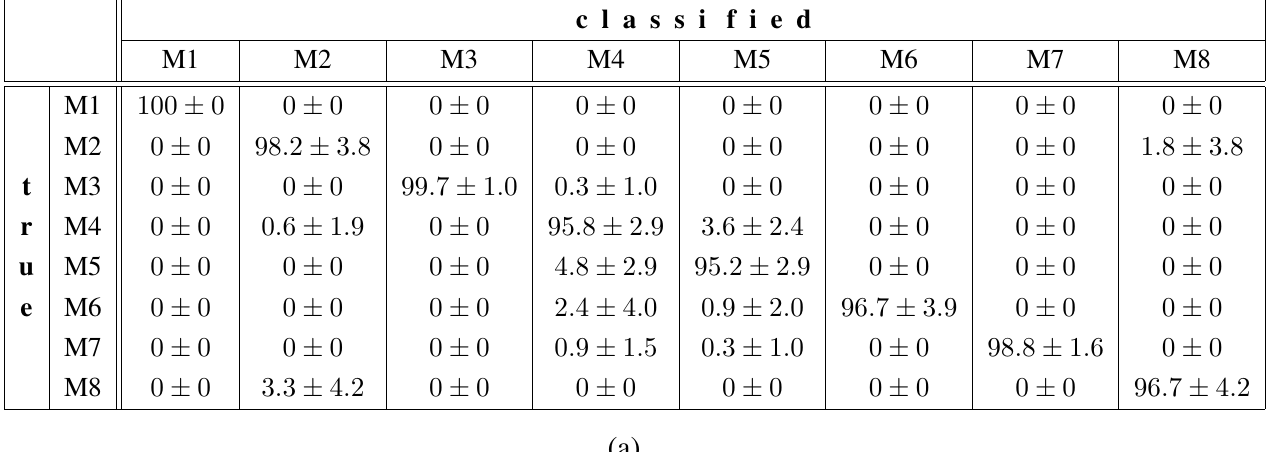
Table 5. Confusion matrices representing the mean and one standard deviation calculated over 10 iterations when the ANN parameters are randomly initialized and (a) the same training and test data sets are used in each iteration and (b) different training and test data sets are randomly constructed in each